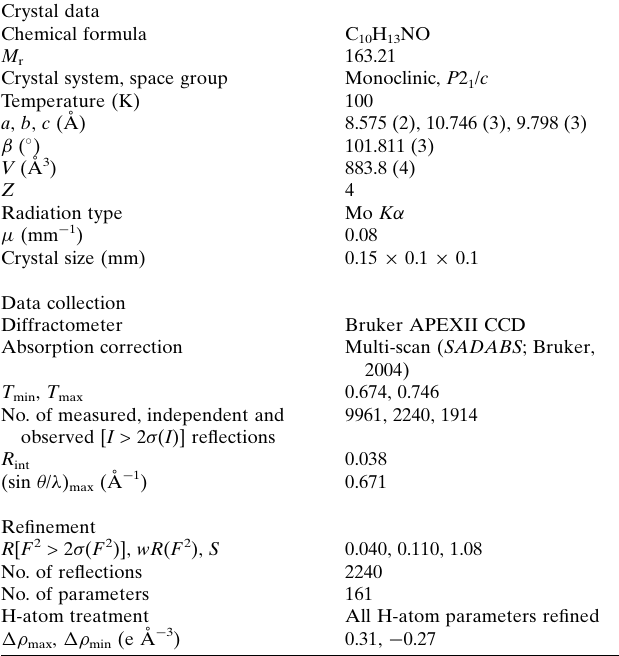
Table 3 Experimental details. Crystal data Chemical